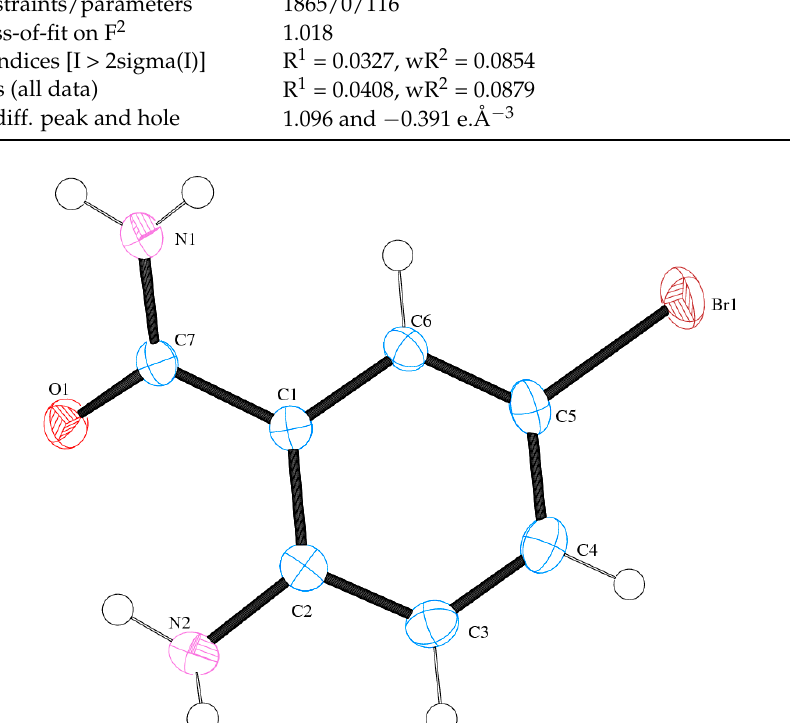
Figure 6. The Oak Ridge Thermal Ellipsoid Plot (ORTEP) diagram of ABB showing crystallographic labelling.